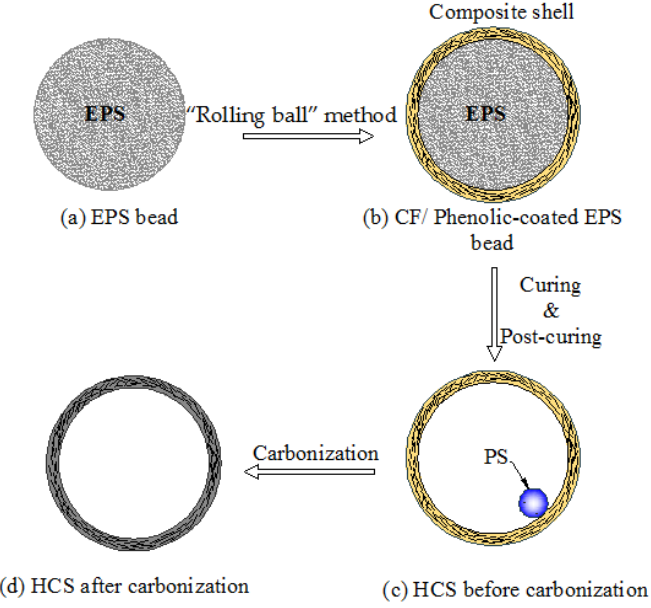
Figure 1. The flow chart illustration of a process for producing hollow carbon spheres (HCSs):( a ) Expanded polystyrene (EPS) bead; ( b ) Carbon Fiber (CF)/Phenolic-coated EPS bead; ( c ) HCS before carbonization; ( d ) HCS after carbonization.